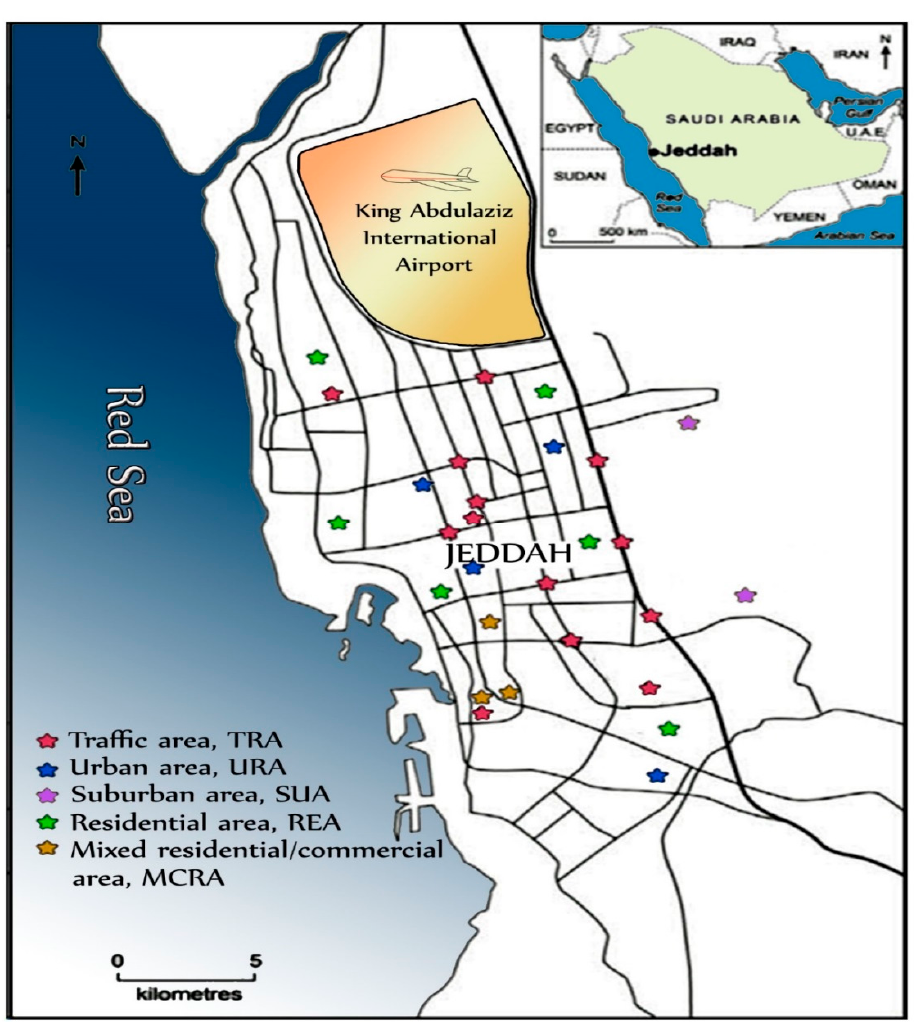
Figure 1. Sampling site distribution in the different land use patterns in Jeddah.